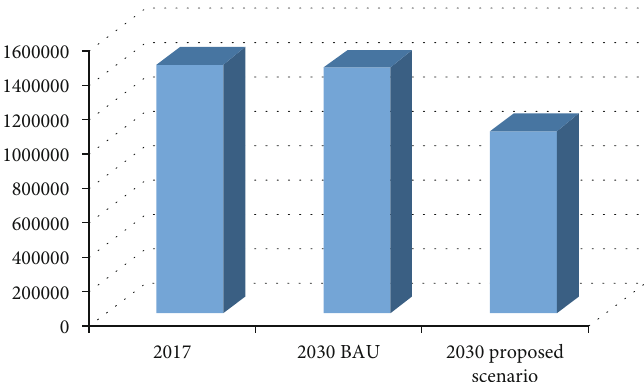
Figure 4: Greenhouse gas emissions by buildings sector of 2017, 2030 BAU and 2030 proposed scenario.